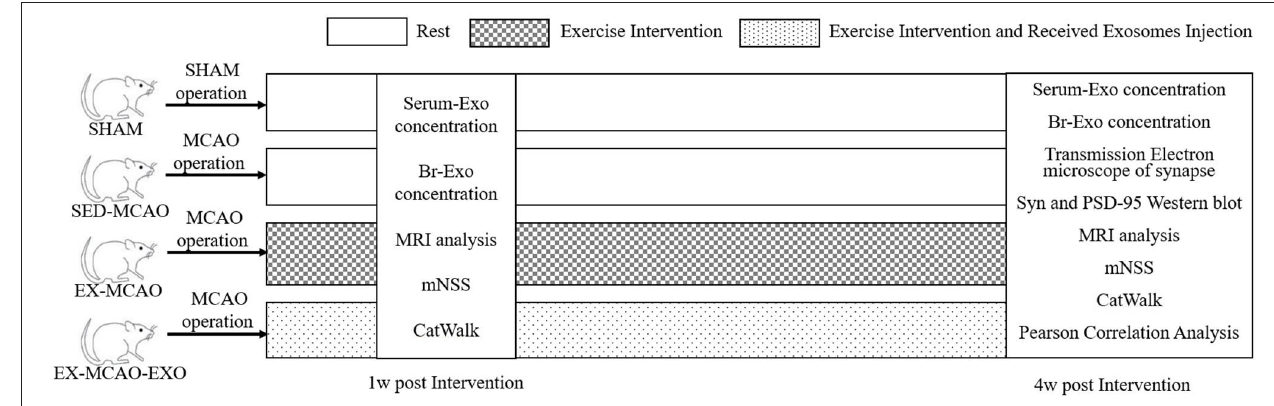
FIGURE 1 | Schematic of the experimental